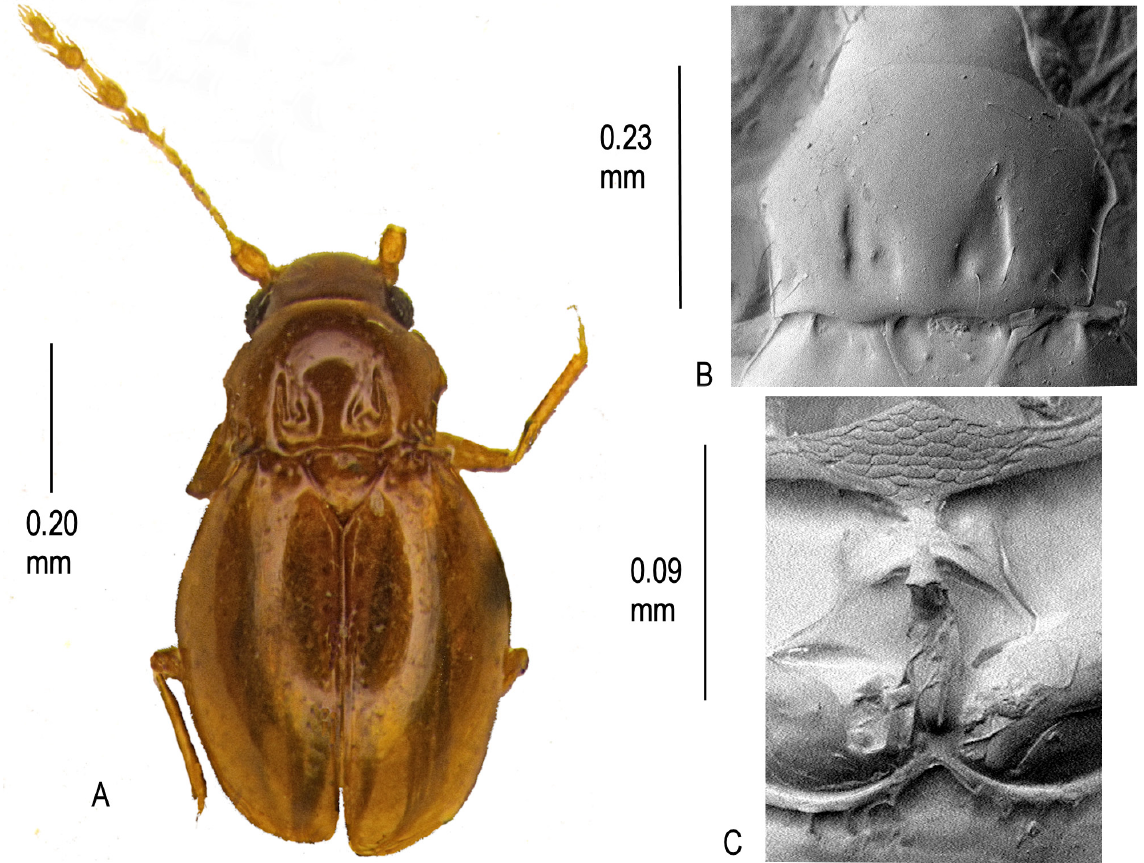
Fig. 12 . Cissidium semicalvum sp. nov. A . Habitus. B . Pronotum, × 520. C . Mesoventrite showing median process of collar, mid-keel and keel, ×